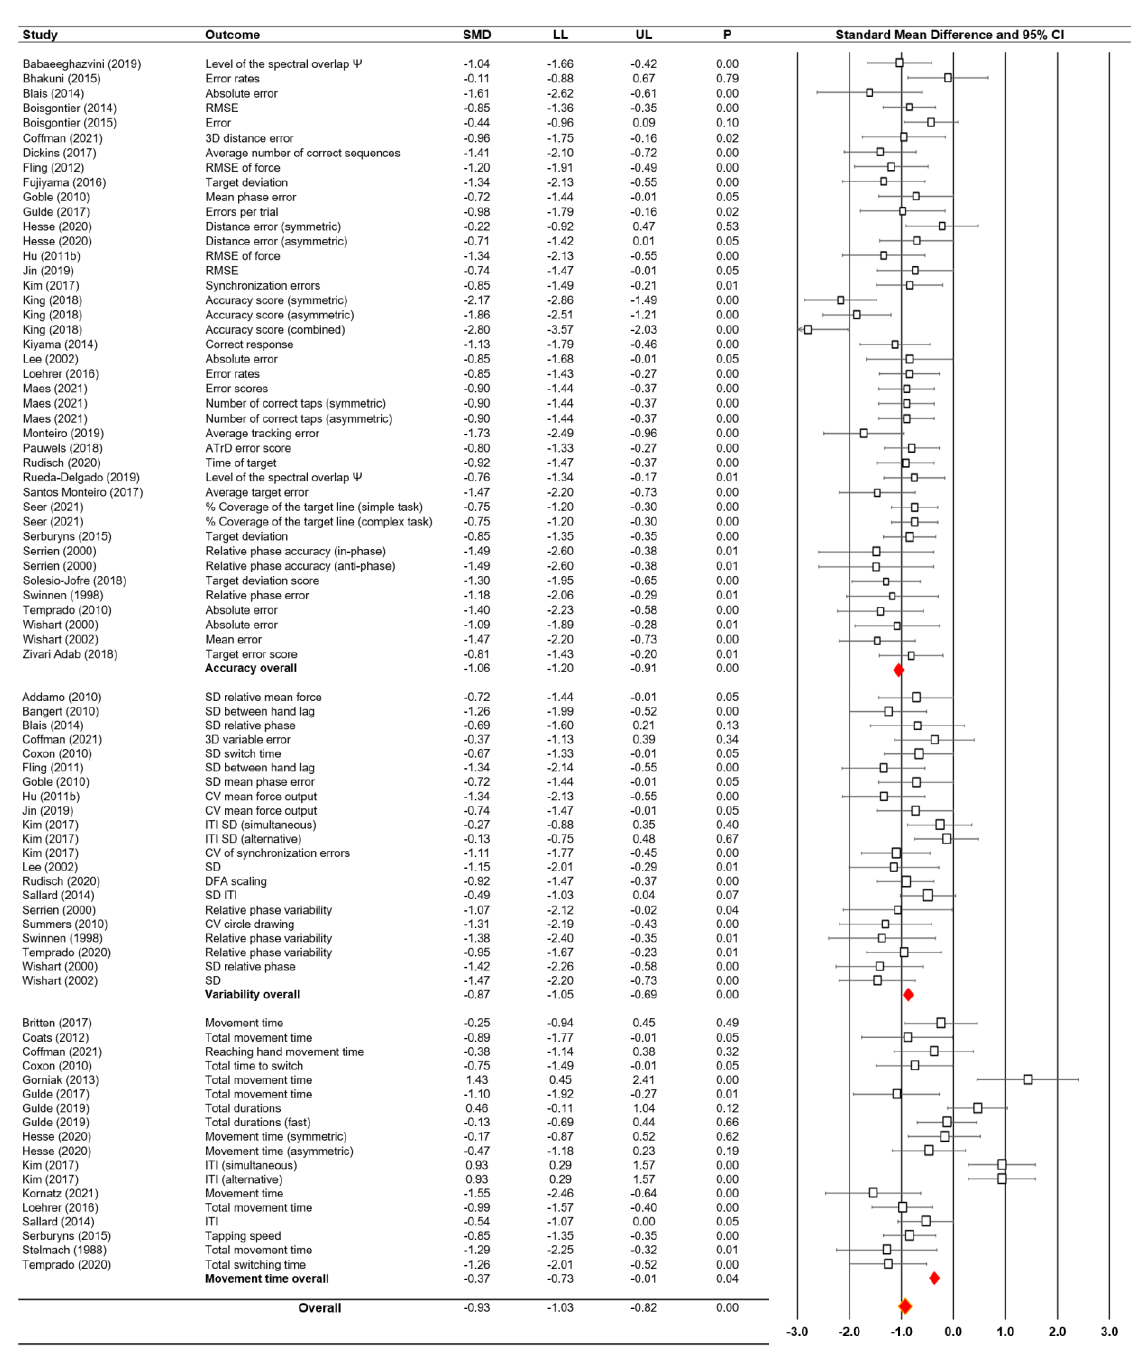
Figure 4: Moderator variable analysis findings on different outcome measures and forest plot for biman- ual motor performance in older adults versus younger